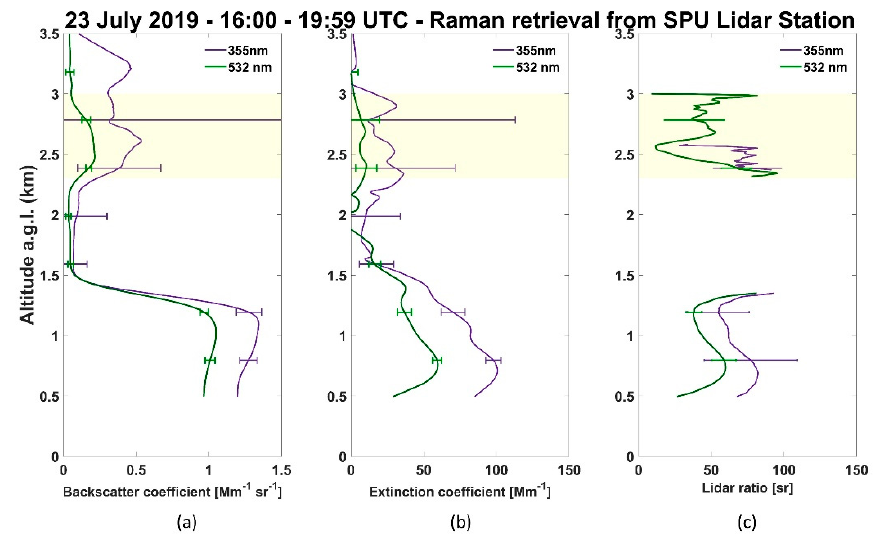
Figure 7. Profiles of the backscatter ( a ) and extinction ( b ) coefficients, and light detection and ranging (lidar) ratios ( c ) retrieved on 23 July 2019, from 532 nm and 355 nm channels, between 16:00 UTC and 20:00 UTC.